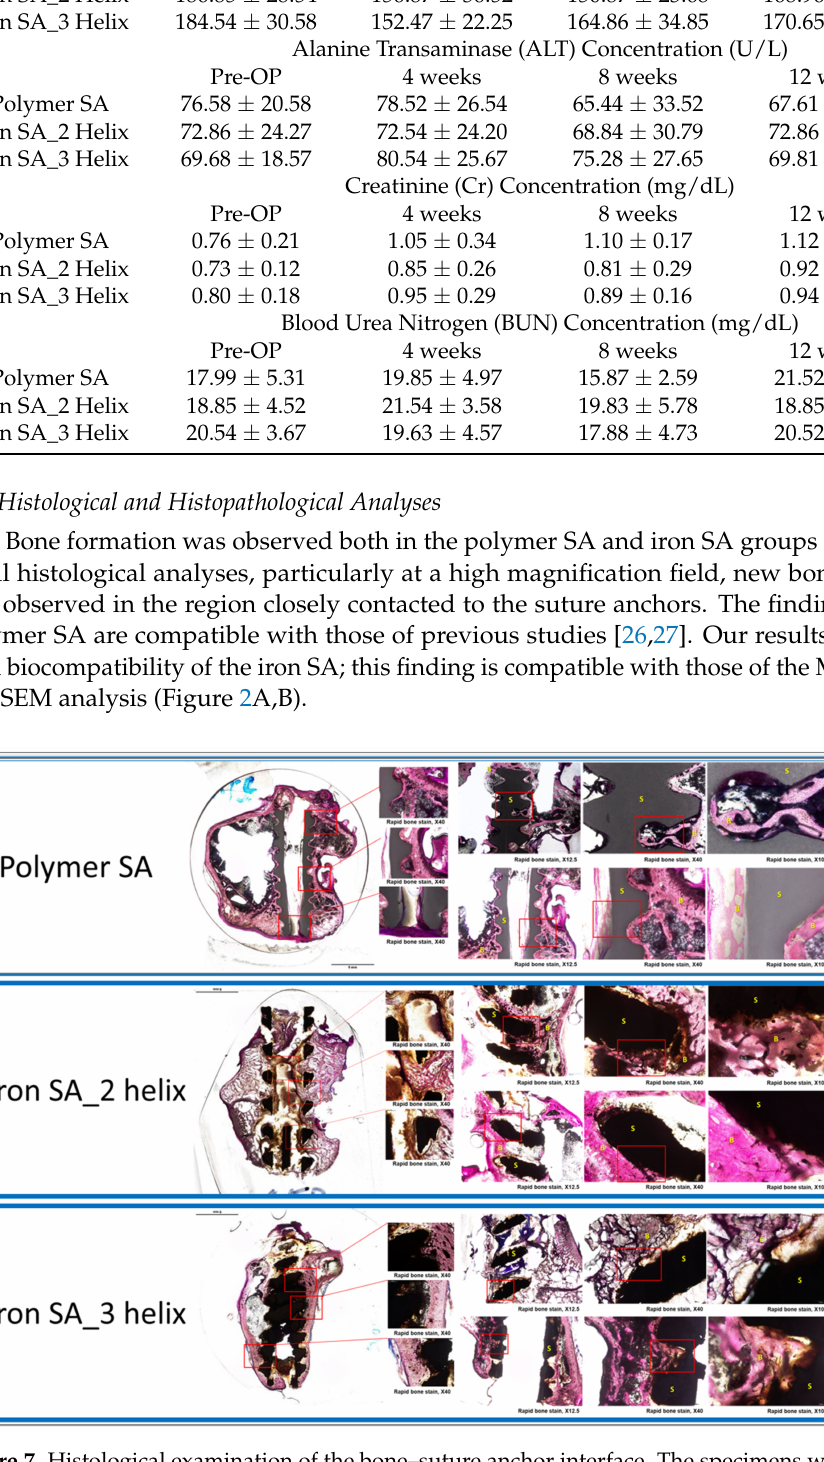
Figure 7. Histological examination of the bone–suture anchor interface. The specimens were stained with Sanderson’s rapid bone stain and then counterstained with acid fuchsin. Scale from 12.5 × , 40 × , and 100 × , respectively. B: bone, S: suture